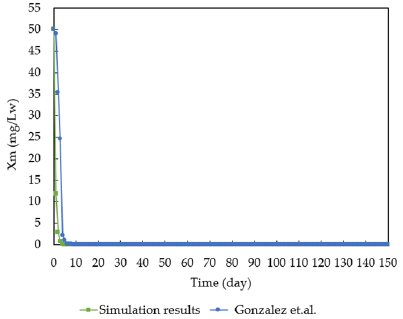
Figure 4. The behavior of (X m ) validation [24].